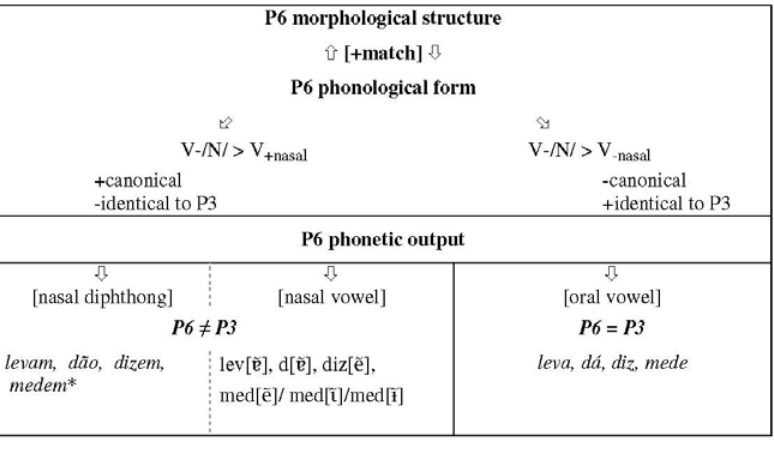
Table 3 – The matching between the P6 morphological and phonological structure, and the /(vowel)N/ phonetic resolution: type of matching